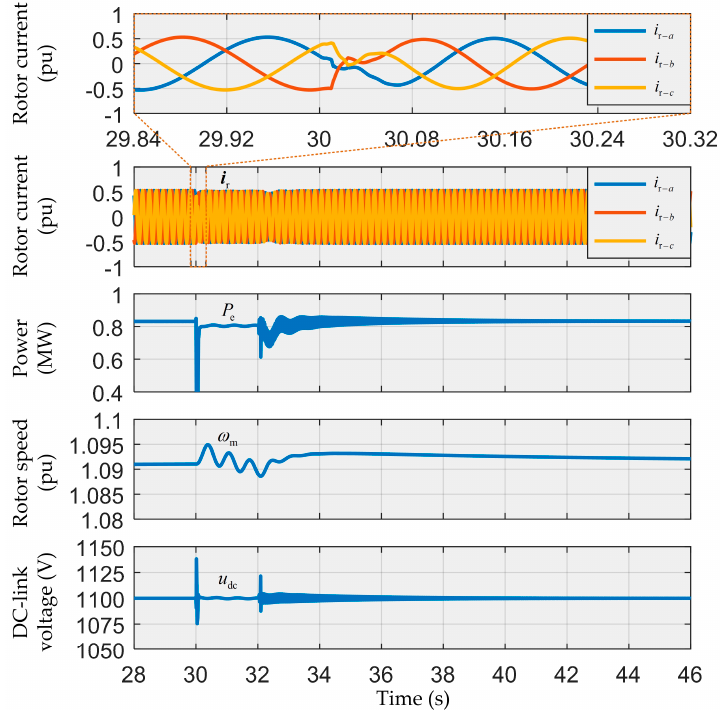
Figure 9. Major changes of electric and mechanical quantity at the wind turbine side in Scenario 2.